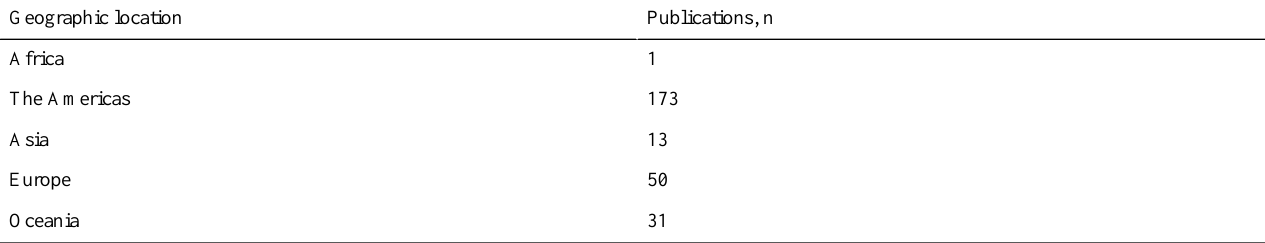
Table 3. Distribution of publications by geographic location (as assessed by the location of the corresponding author).